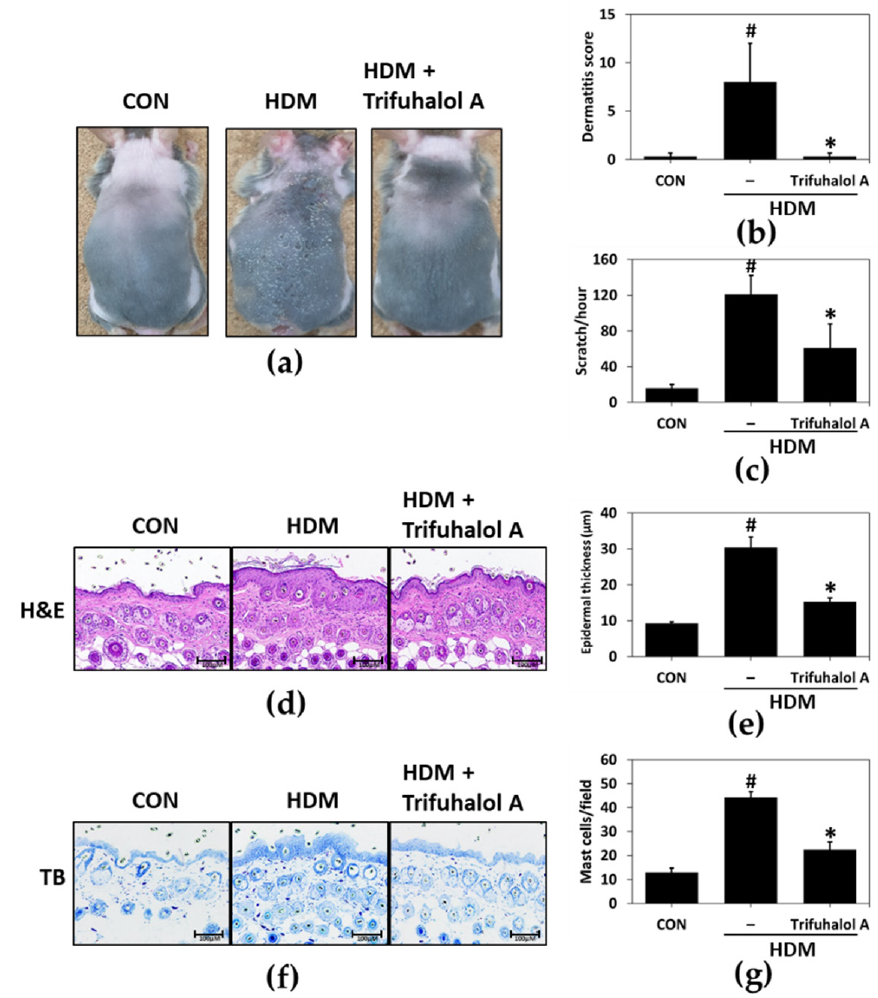
Figure 4. Effects of trifuhalol A on HDM-induced AD-like symptoms in the dorsal skin of NC/Nga mice. ( a ) Clinical features of trifuhalol A treatment. (n = 5 in each group). ( b ) The dermatitis score was evaluated by scoring the skin lesions according to symptoms such as erythema/hemorrhage, scarring, edema, and excoriation/erosion. Each bar represents the mean ± S.D. (n = 5 in each group). # p < 0.05 vs. control group; * p < 0.05 vs. HDM group. ( c ) Scratching behavior was observed for 1 h at the end of the experiment. Each bar represents the mean ± S.D. (n = 5 in each group). # p < 0.05 vs. control group; * p < 0.05 vs. HDM group. ( d ) Histopathological features induced by hematoxylin and eosin staining of dorsal skin lesions (magnification × 100) and ( e ) measured epidermal thicknesses. Each bar represents the mean ± S.D (n = 5 in each group). # p < 0.05 vs. control group; * p < 0.05 vs. HDM group. ( f ) Infiltrated mast cells were shown through toluidine blue staining of dorsal skin lesions (magnification × 100), and ( g ) the number of mast cells per dermis. Each bar represents the mean ± S.D (n = 5 in each group). # p < 0.05 vs. control group; * p < 0.05 vs. HDM group. The application of HDM causes an increase in serum IgE and IL-4 production in rodent allergy models [15]. According to the results of the serum test, IgE and IL-4 levels increased in the HDM-stimulated group. Hence, trifuhalol A application noticeably attenuated serum IgE (Figure 5a) and IL-4 (Figure 5b) concentrations in HDM-induced AD